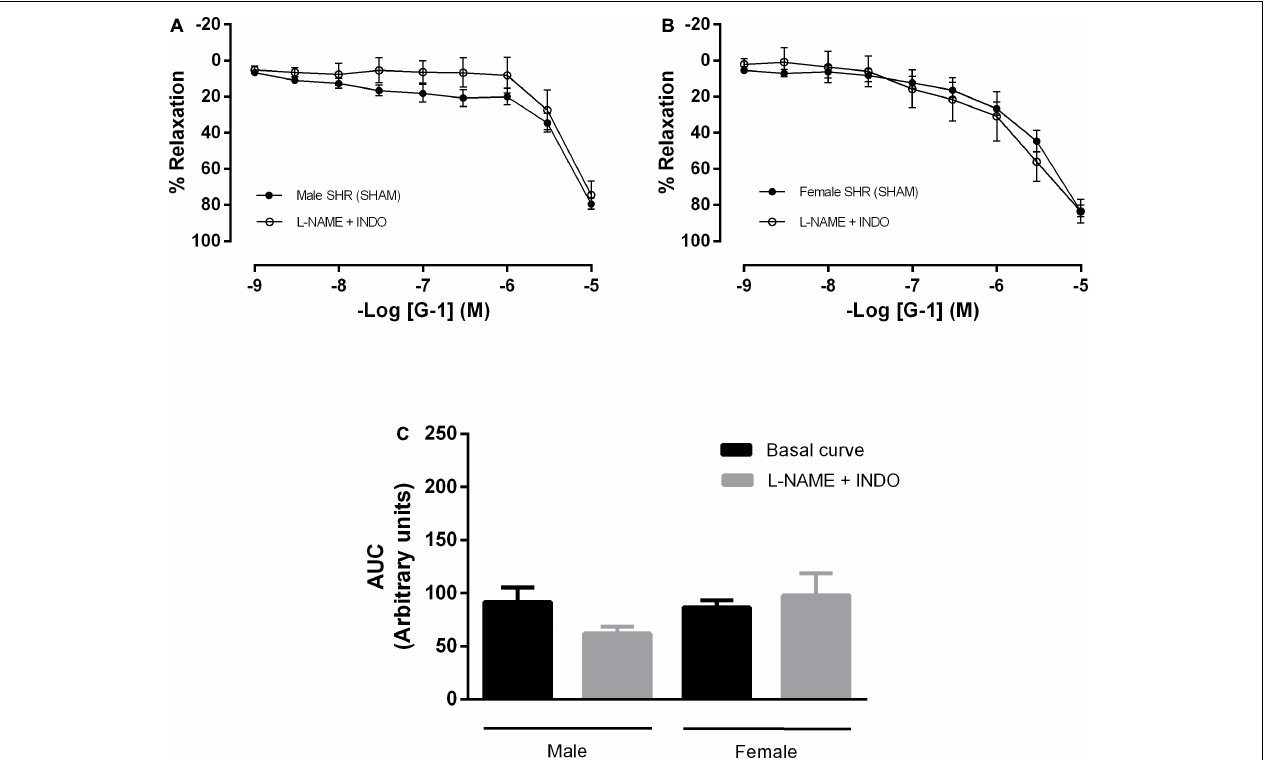
FIGURE 5 | Conjugated inhibition of the NO and prostanoids pathways, without changes in the vasodilator response induced by G-1, indicates the participation of endothelium-dependent hyperpolarization in both sexes. Effect of non-selective nitric oxide synthase inhibition with N ω -nitro-L-arginine methyl ester (L-NAME, 300 µ M) and cyclooxygenase inhibition with indomethacin (INDO, 10 µ M) in (A) Male ( n = 8) and (B) Female ( n = 7) SHR groups. (C) Area under the curve (AUC) before and after L-NAME and INDO incubation. Values are expressed as mean ± SEM. The curve analysis was carried out point-by-point through two-way ANOVA, followed by the Sidak post hoc test. AUCs were evaluated through one-way ANOVA followed by Tukey post hoc test.